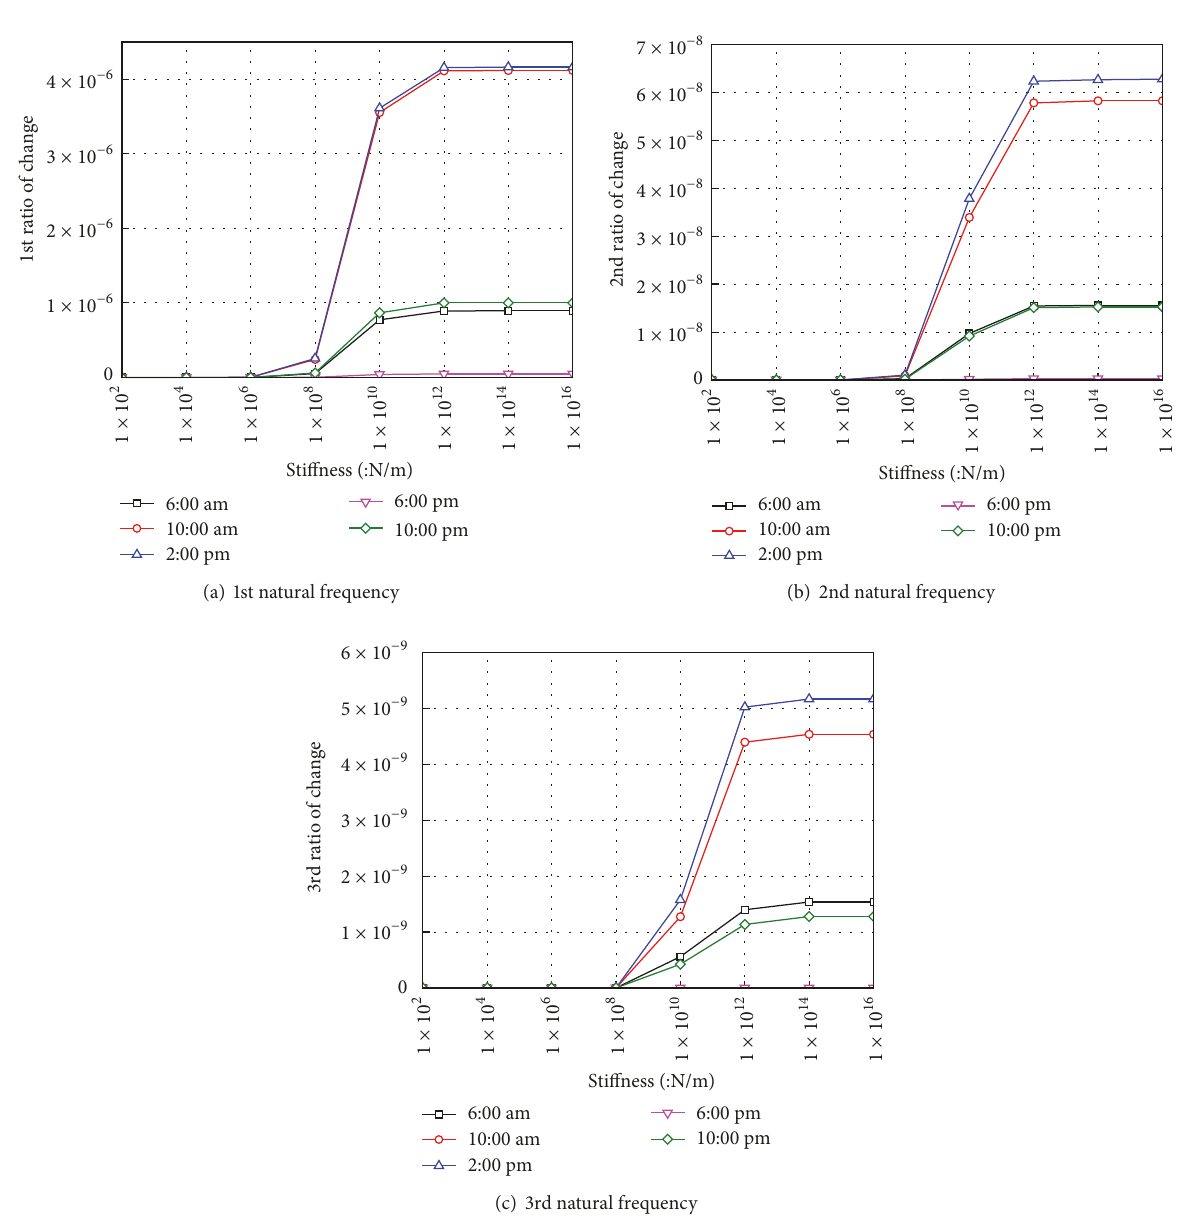
Figure 17: The ratio of change for the first three natural frequencies of beam under different shear stiffness of bearing.